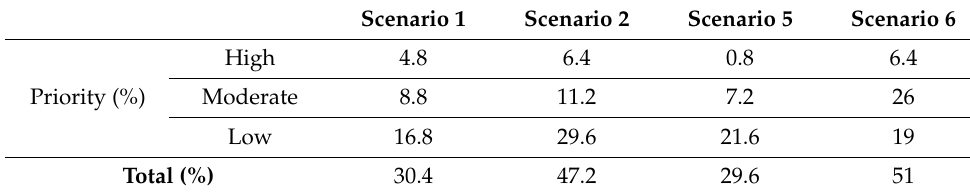
Table 17. Percentage of common sub-catchments falling under each priority